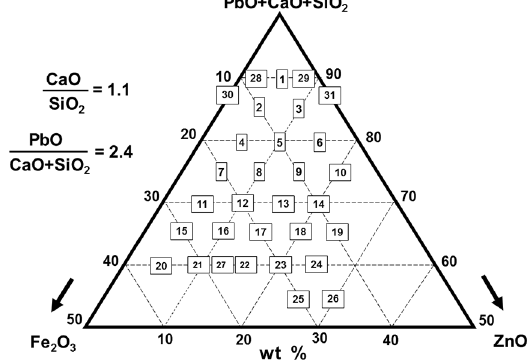
Figure 2. Schematic representation of the slag compositions.